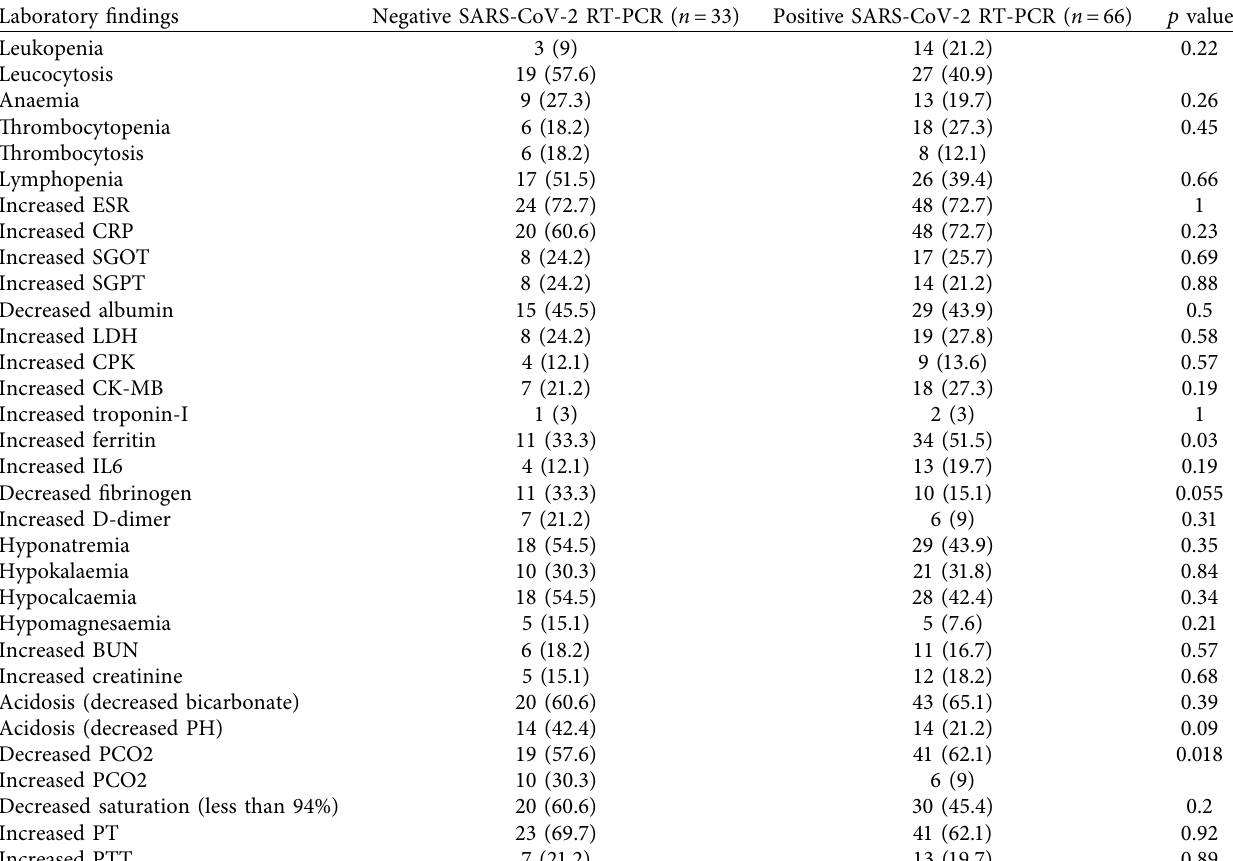
Table 3: Laboratory findings of the cases with positive and negative SARS-CoV-2